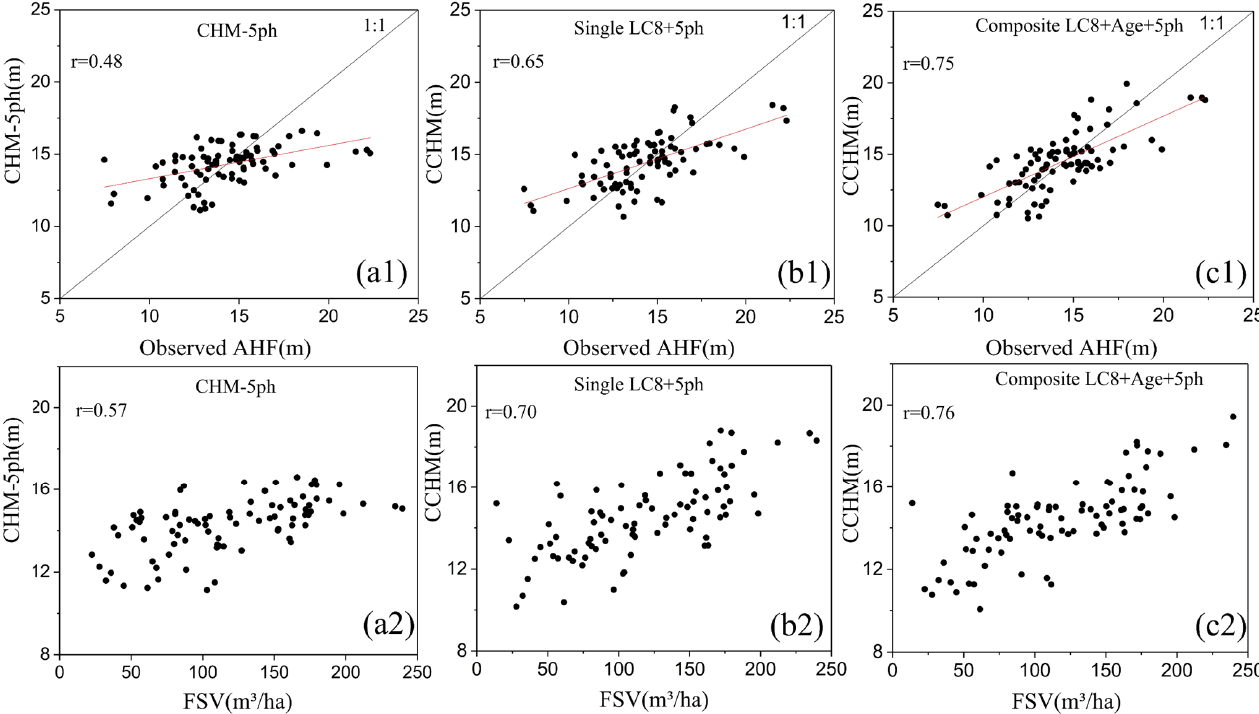
Figure 8. The scatterplots between CHM, AHF and FSV: ( a1 ) is the scatterplot between 5ph and AHF; ( b1 , c1 ) are scatterplots between CCHM derived from single and composite LC8 and AHF, respectively; ( a2 – c2 ) are the scatterplots between 5ph, CCHM and